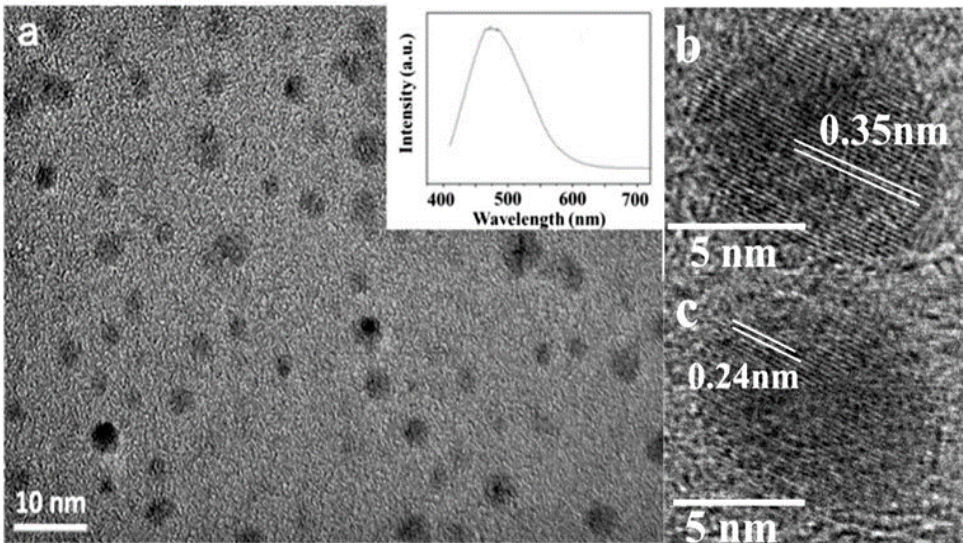
Figure 1. ( a ) TEM images of graphene quantum dots (GQDs) of different sizes and the photoluminescence spectrum excited at 400 nm. ( b , c ) High-resolution transmission electron microscopy (HRTEM) images of GQDs. Taken from Wu et al. [32] .